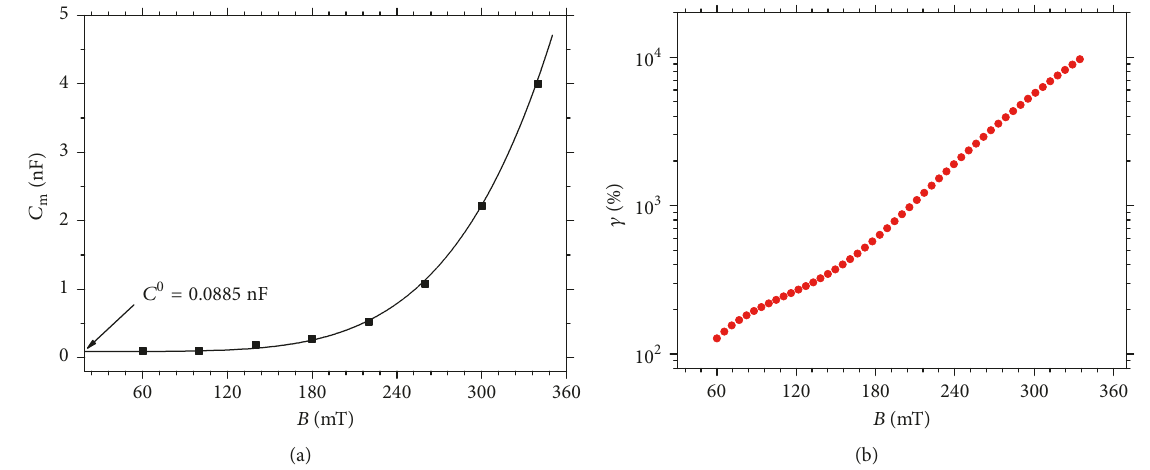
Figure 8: Average electrical capacitance 𝐶 𝑚 (a) and the ratio 𝛾 = (𝐶 𝑚 /𝐶 0 − 1) × 100 (b) of hMRE as a function of magnetic flux density 𝐵 . Dots, experimental data; continuous black curve, fit using